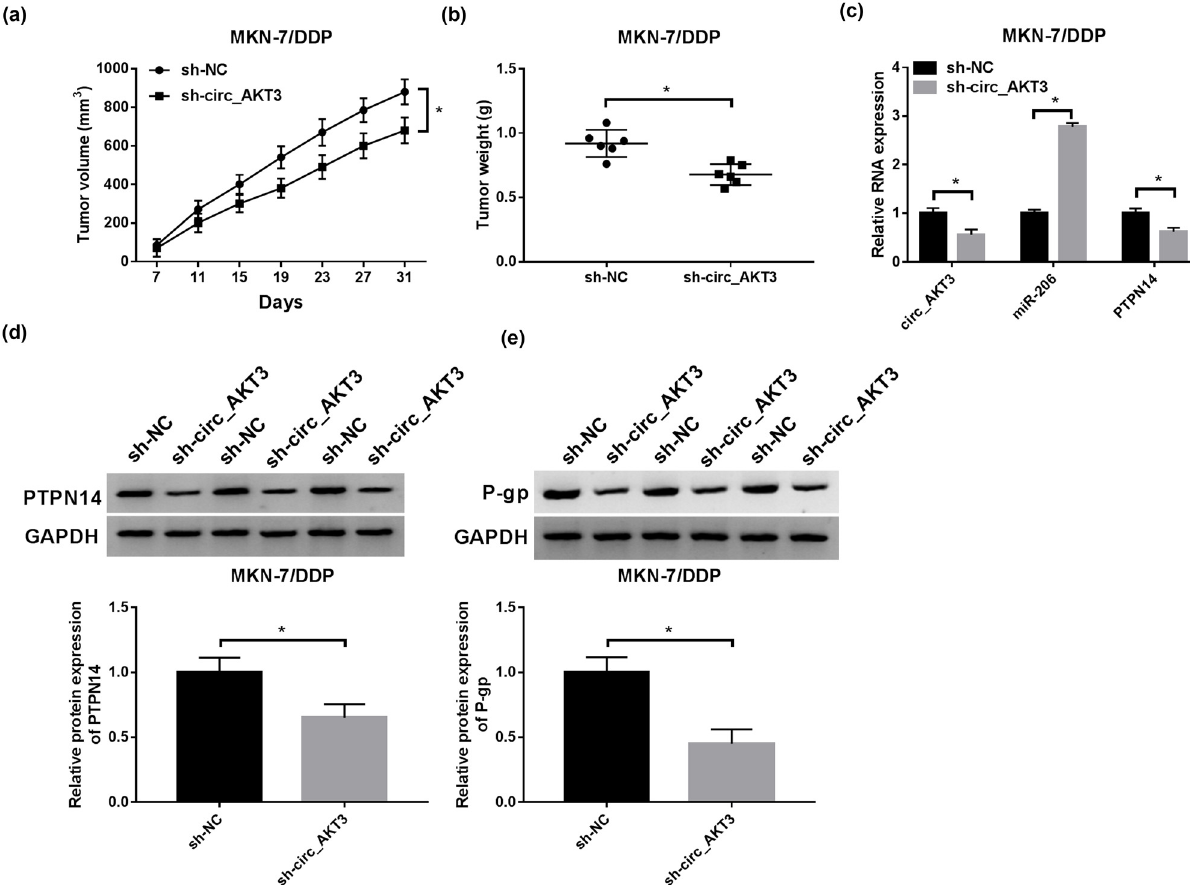
Figure 8: Knockdown of circ_AKT3 reduces xenograft tumor growth. MKN - 7/DDP cells stably transfected with sh - circ_AKT3 or sh - NC were used for establishment of xenograft model. ( a ) Tumor volume was detected every 4 days. ( b ) Weight of tumor tissues was measured at the end point. ( c – e ) The levels of circ_AKT3, miR - 206, PTPN14 and P - gp were detected in each group. * P <